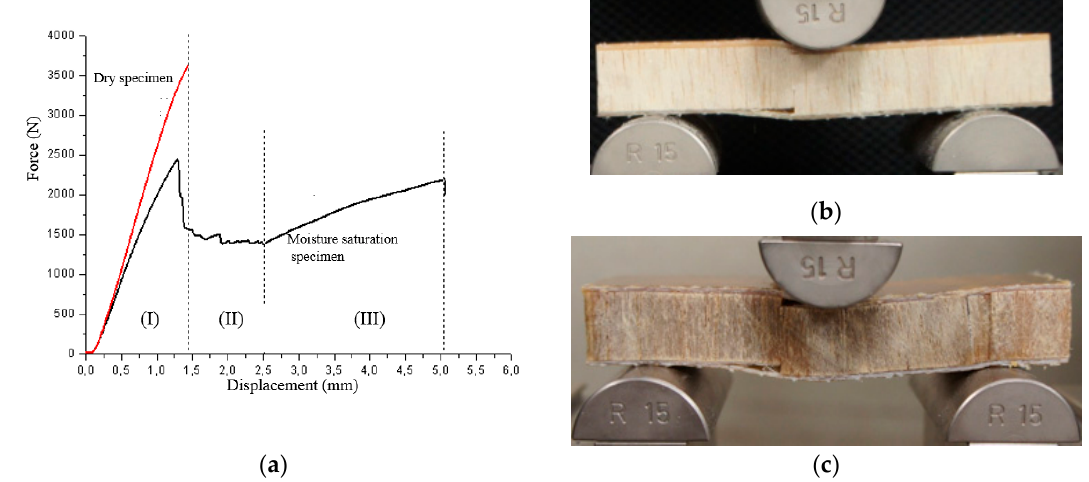
Figure 7. Three-point bending test: Force—displacement curve of the dry and water saturation sandwich specimens ( a ), failure mode of dry sandwich specimen ( b ) and water saturation sandwich specimen ( c ).